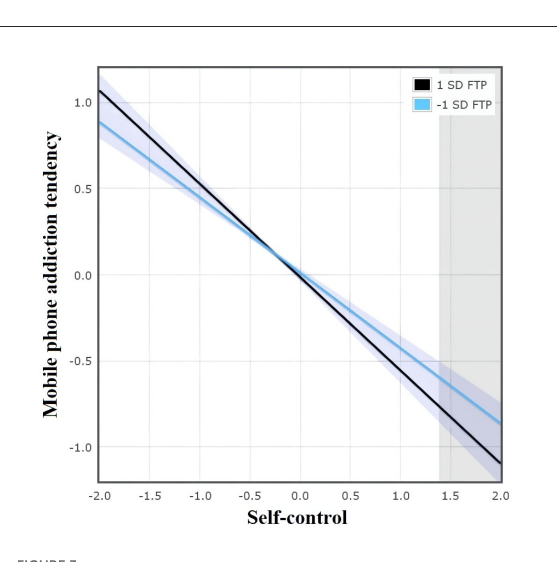
FIGURE3 The simple slope of self on the mobile phone addiction tendency at different levels of